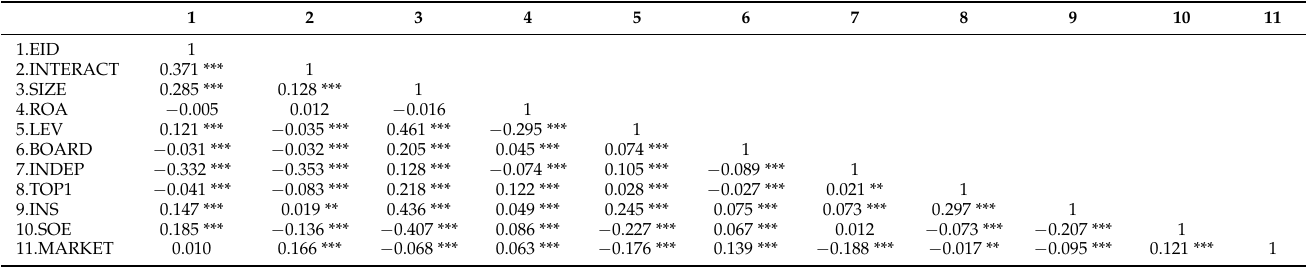
Table 3. Correlation